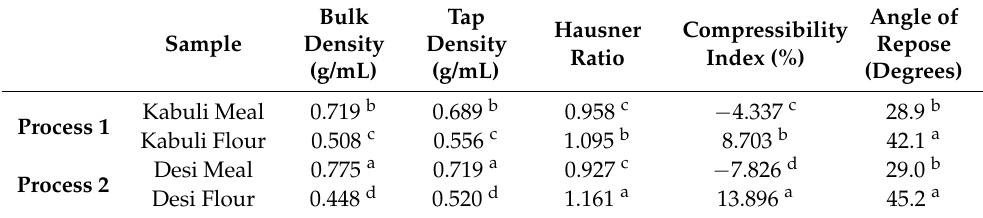
Table 5. Flow properties’ data of kabuli and desi chickpea meal and